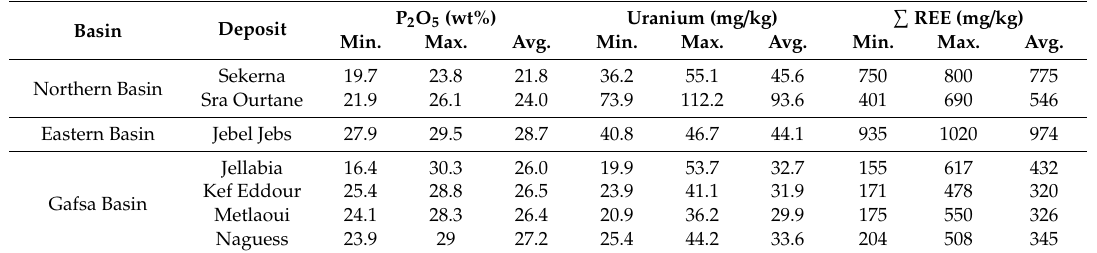
Table 1. Potential P 2 O 5 , Uranium, and Rare Earth Element (REE) Concentrations in Some Tunisian Phosphate Rock Deposits [19,20].